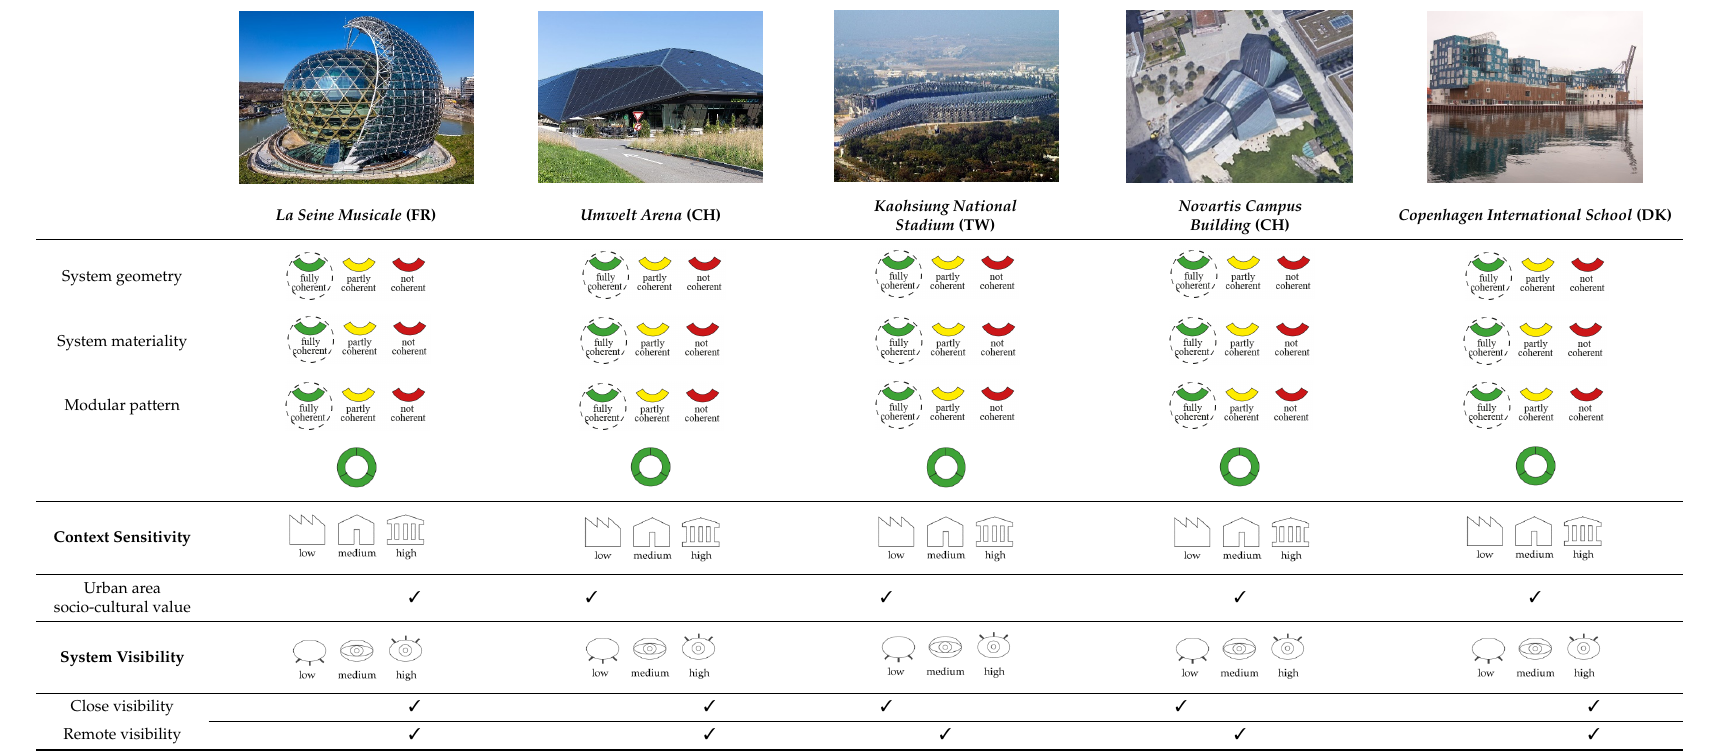
Table 5. Architectural integration quality, context sensitivity and system visibility of the landmark buildings (second part).